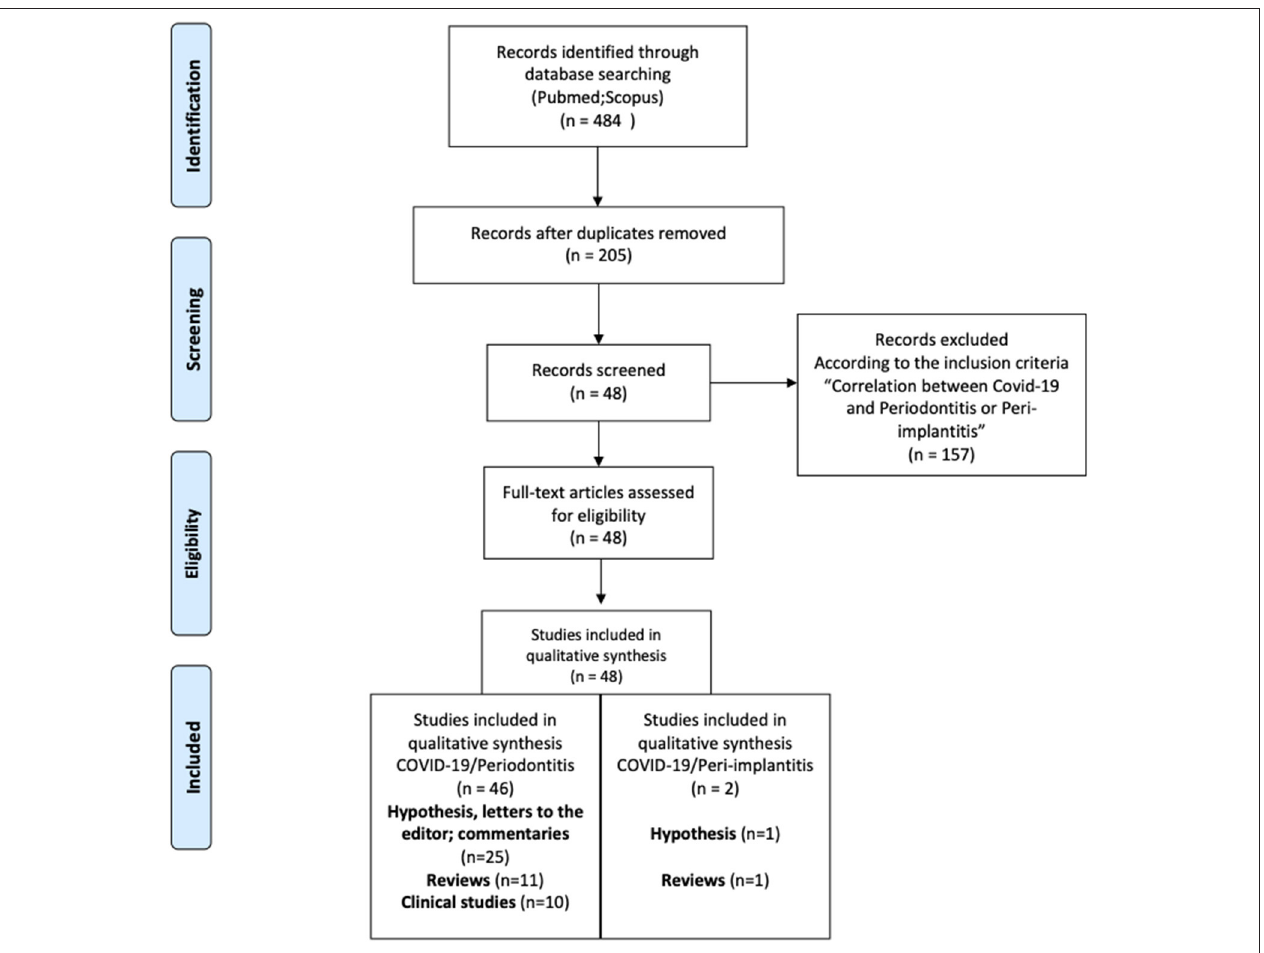
FIGURE 1 | Flow chart for the inclusion and exclusion